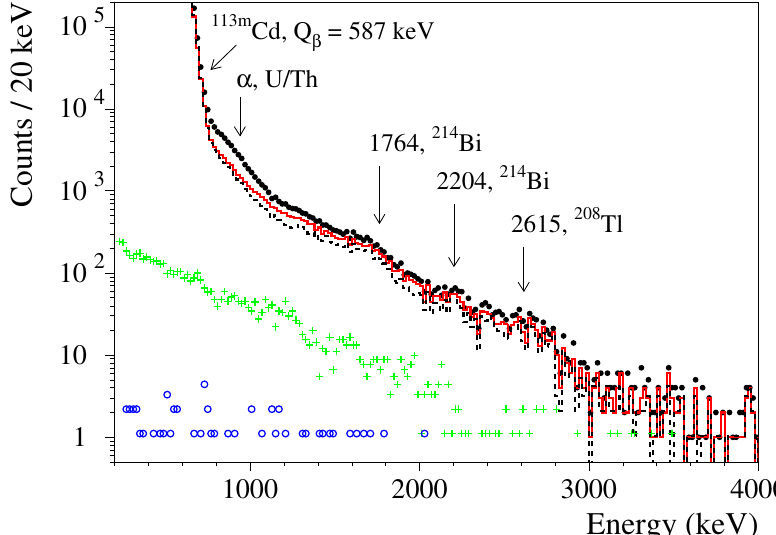
Figure 6. Energy spectra measured by the 106 CdWO 4 detector for 26,033 h in the low-background set-up without selection cuts (black dots), after selection of γ and β events by PSD using the mean time method (solid red line), the γ and β events in anti-coincidence with the CdWO 4 counters (dashed black line), the γ and β events in coincidence with event(s) in at least one of the CdWO 4 counters with the energy E = 511 ± 2 σ keV (green crosses), the γ , and β events in coincidence with events in both the CdWO 4 counters with the energy E = 511 ± 2 σ keV (blue